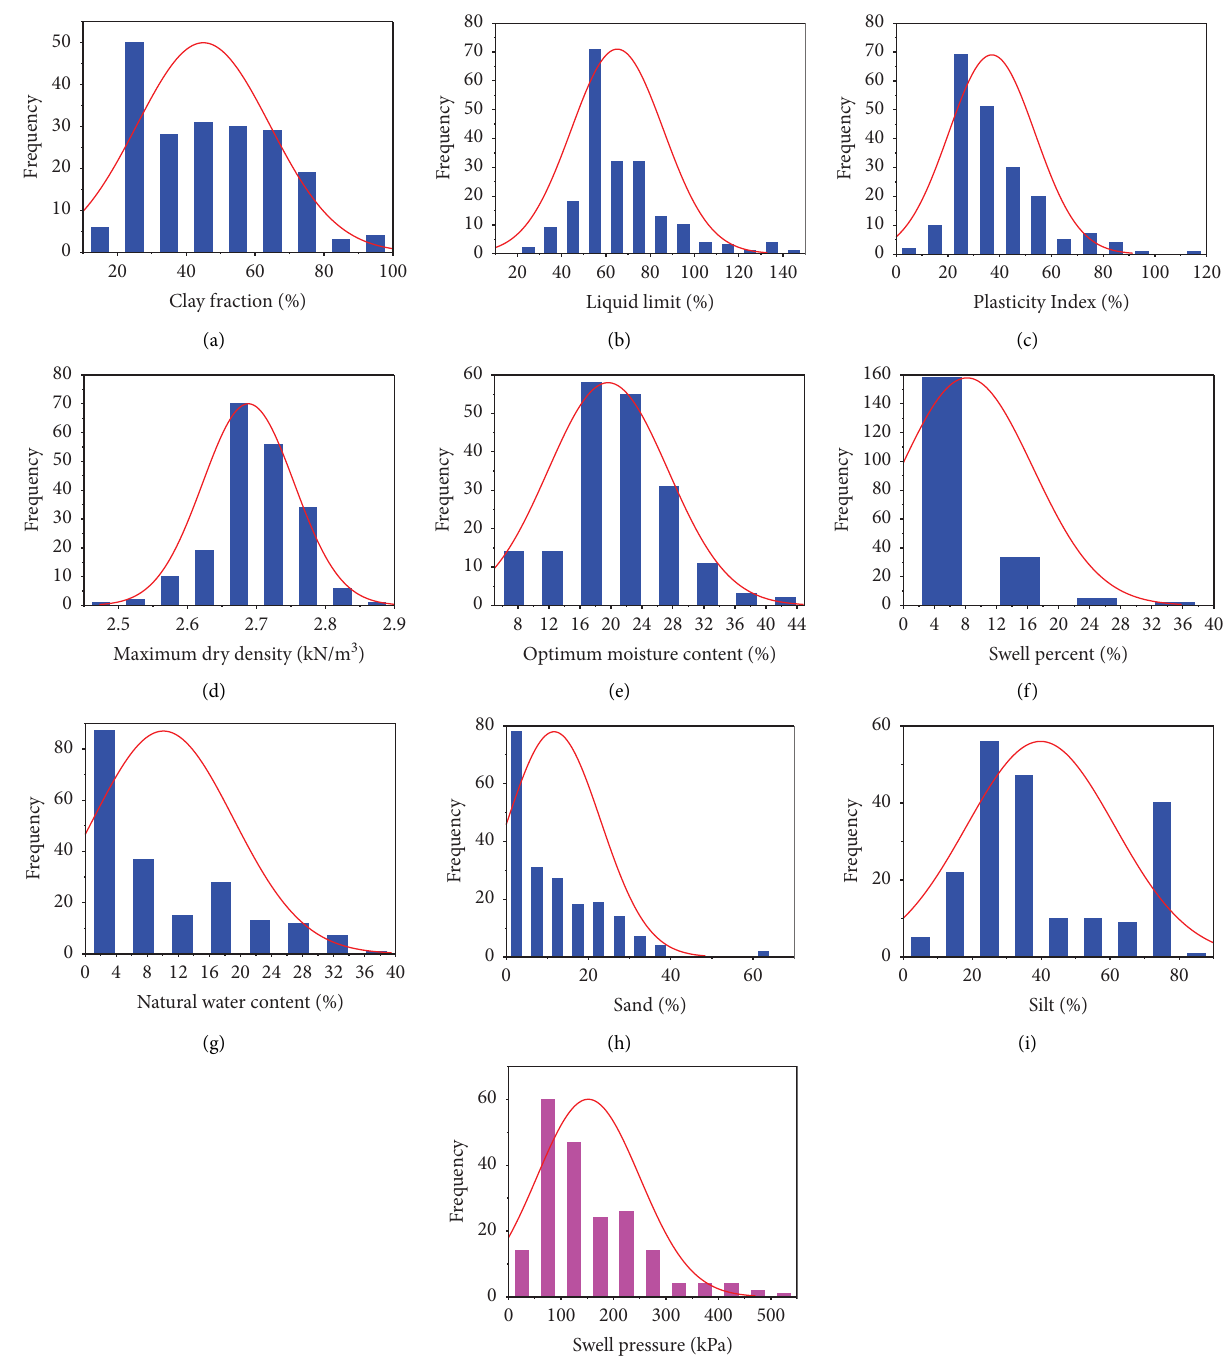
Figure 5: Histograms of used input parameters and output parameter in this